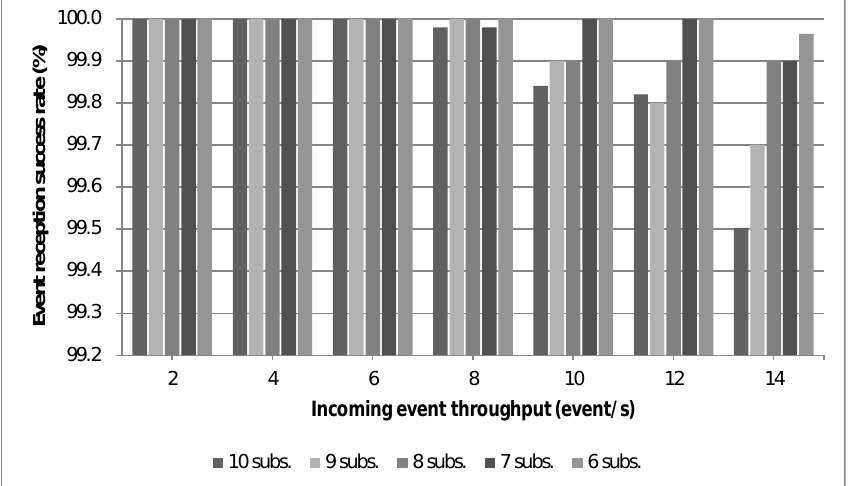
Figure 16. Event reception success rate registered for each of the test